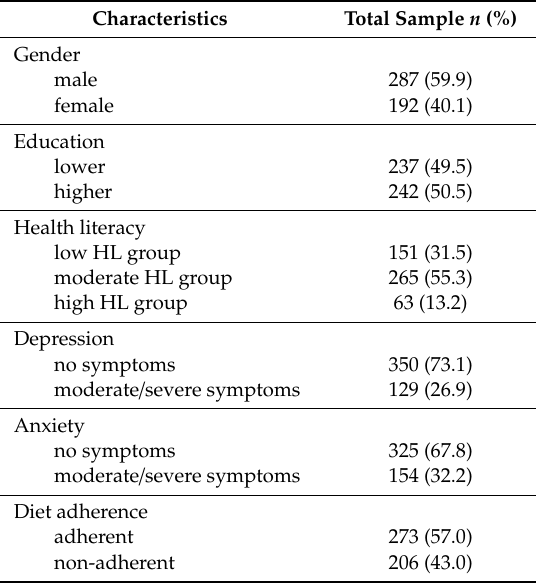
Table 1. Characteristics of the total sample, gender, education, health literacy (HL), depression, anxiety and diet non-adherence ( n =